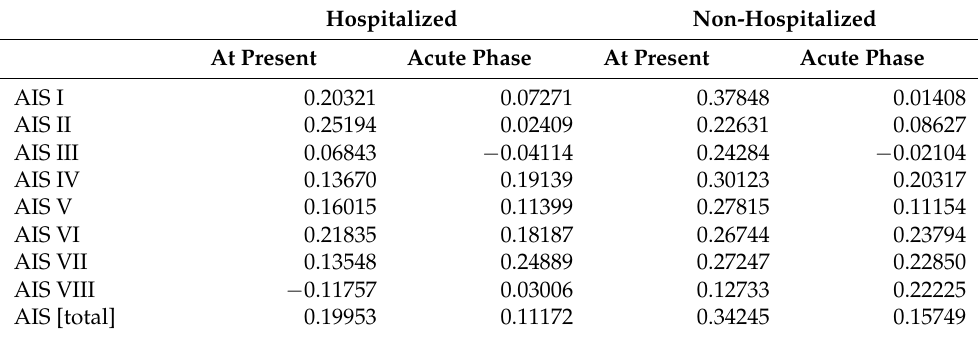
Table 7. Correlation of the results obtained in the AIS with the number of symptoms related to COVID − 19 by hospitalization (Spearman’s